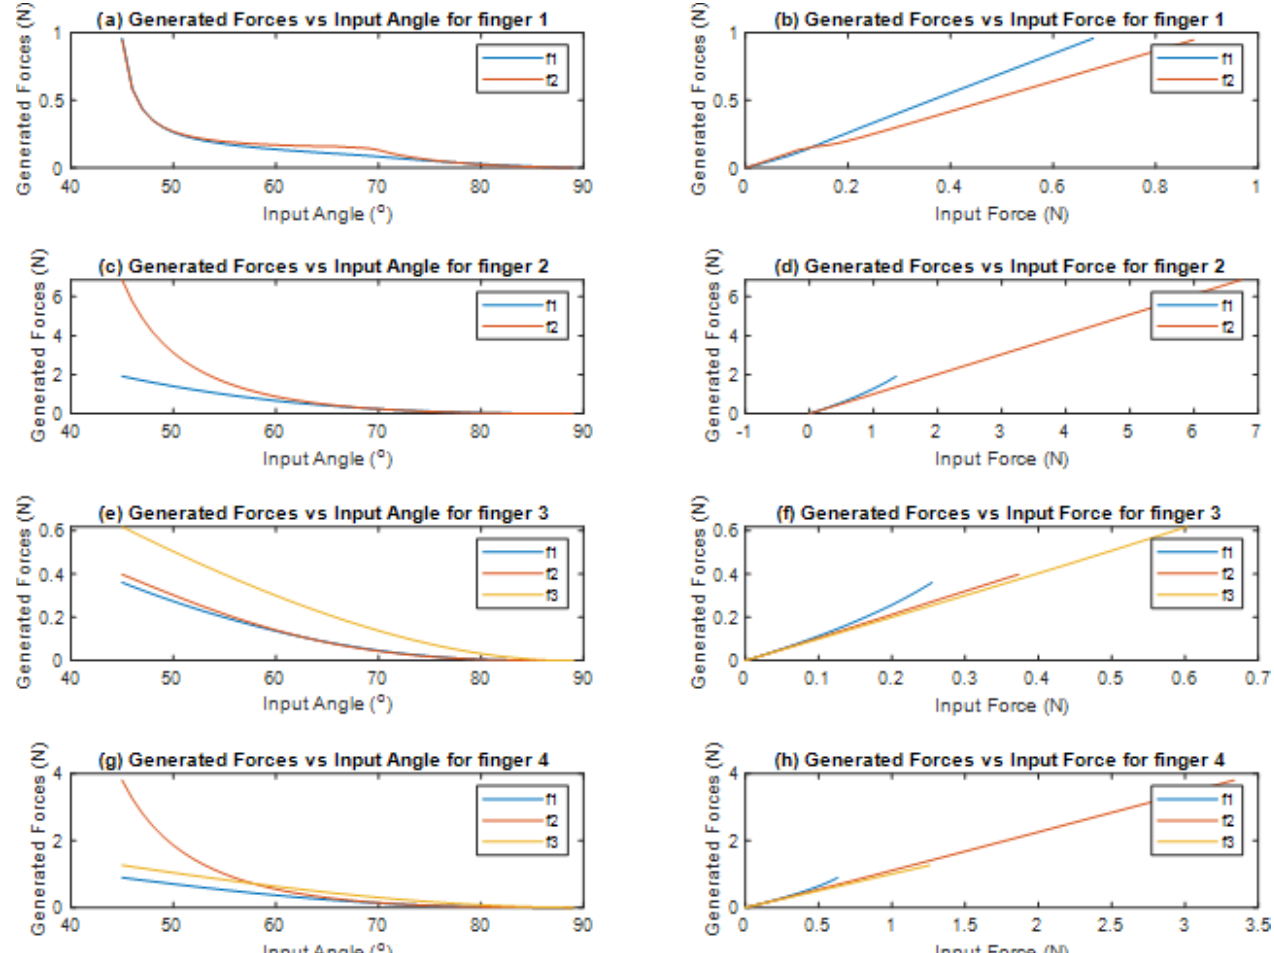
Figure 6. Plots of the generated forces as a function of the input angle and the gripper force for the four fingers.